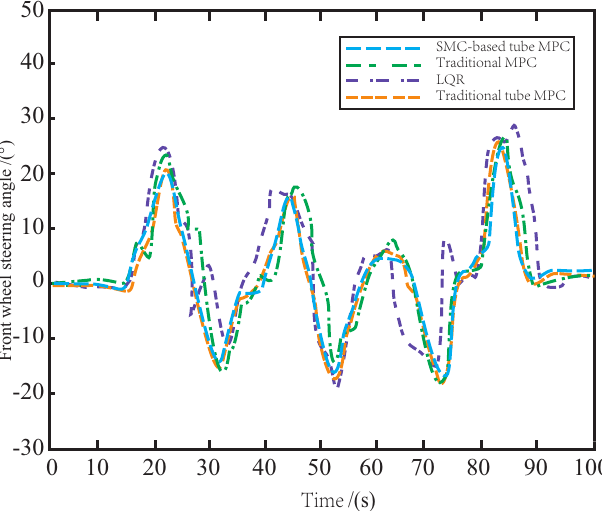
Figure 8. The variation of front wheel angle on the snowy